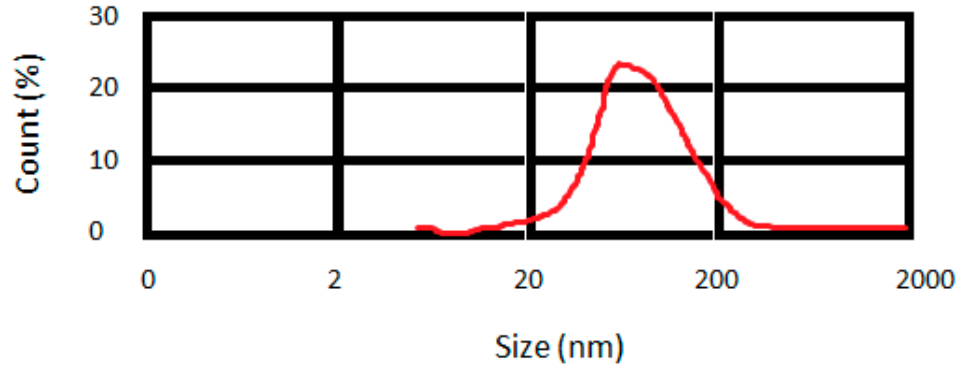
Figure 1. Distribution of particle size for prepared curcumin nanoparticles.